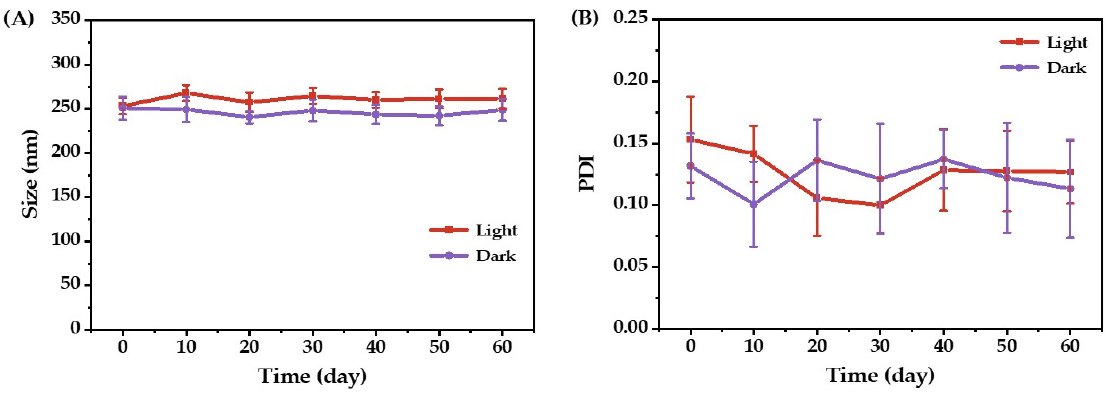
Figure 8. Mean droplet size ( A ) and PDI ( B ) of the optimized O/W emulsion as a function of storage time.